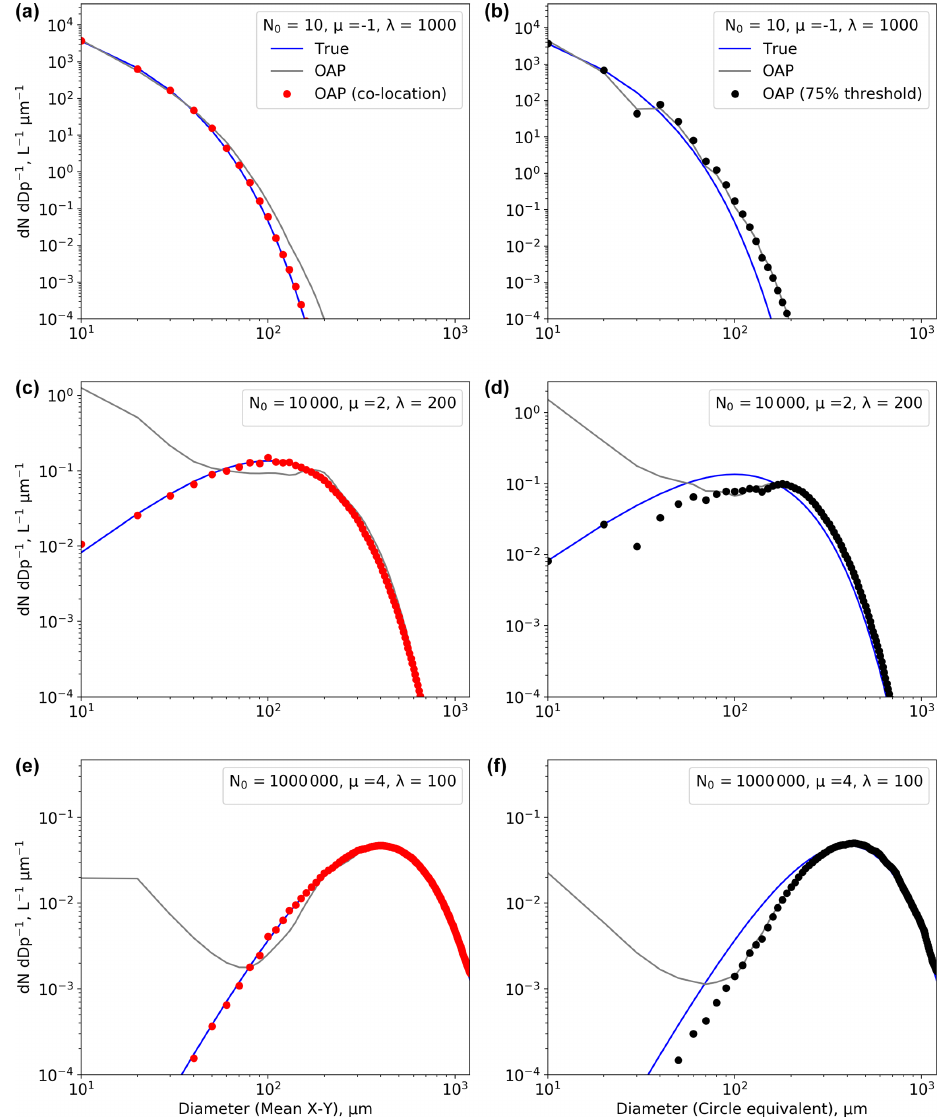
Figure 18. Simulations of OAP measurements of different gamma PSDs (blue lines). The coefficients µ , λ (cm − 1 ), and N 0 (L − 1 cm − 1 ) for each gamma PSD are shown in text boxes. Panels (a) , (c) , and (e) show plots using mean X – Y diameter and panels (b) , (d) , and (f) show circle equivalent diameter. The grey lines show simulated OAP PSDs with arm width of 70mm if all the particles are rosettes. The red markers show simulated 2D-S measurements using only co-located particles, which has the effect of limiting the maximum Z a particle can be observed at to 0.64mm. The blue markers show simulated OAP measurements from a greyscale probe with 70mm arm width when the data have been filtered to only include particles that have at least one pixel with a greater than 75% decrease in light